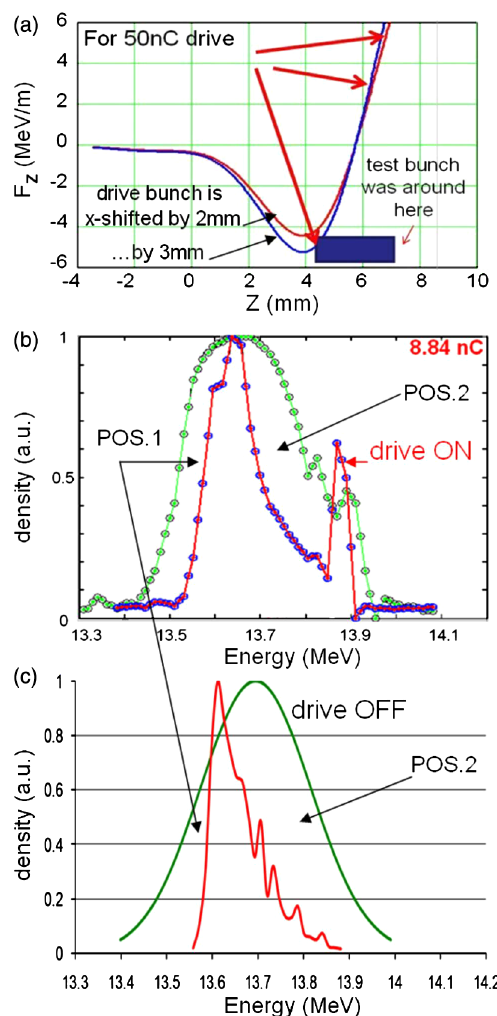
FIG. 12. (a) Simulations of F z for the test channel [values are renormalized to 50 nC (see explanations in the text)] for the delay 5.7 mm. (b) Typical energy distribution (normalized to 1) observed in 80%–85% of shots. (c) CST MICROWAVE STUDIO simulations to predict changes in the energy distribution [for case #1 in Table V, and the drive bunch is shifted off the center of its channel by 2 mm (toward the test